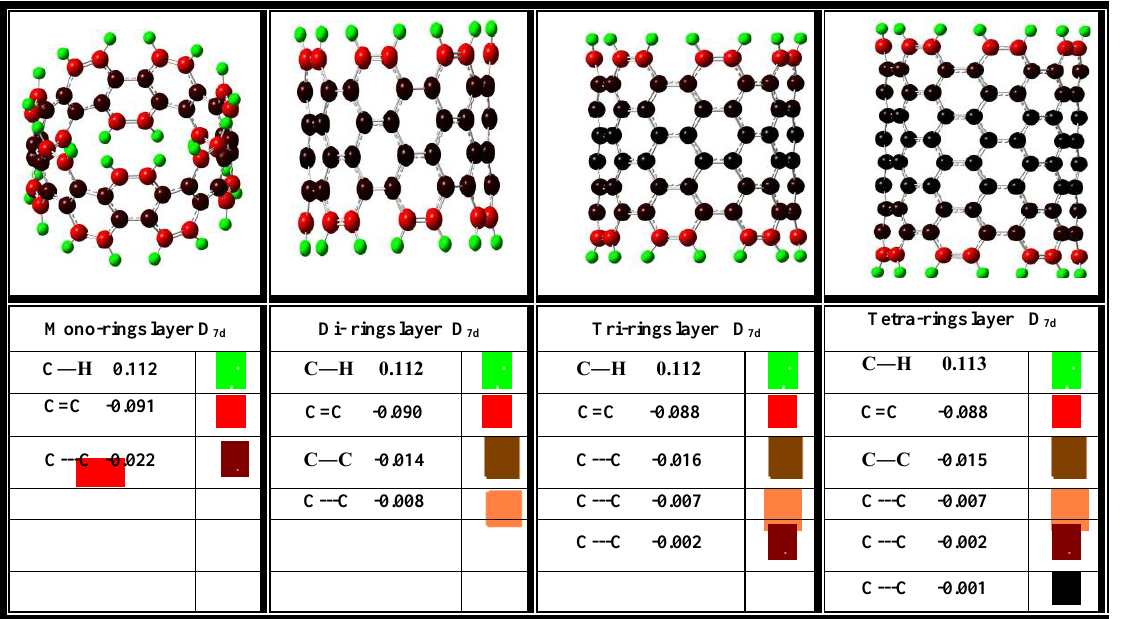
Fig.6: Distribution of charge density at the atoms for (mono, di, tri and tetra) rings layer of (7,7) armchair SWCNT as calculated applying G03